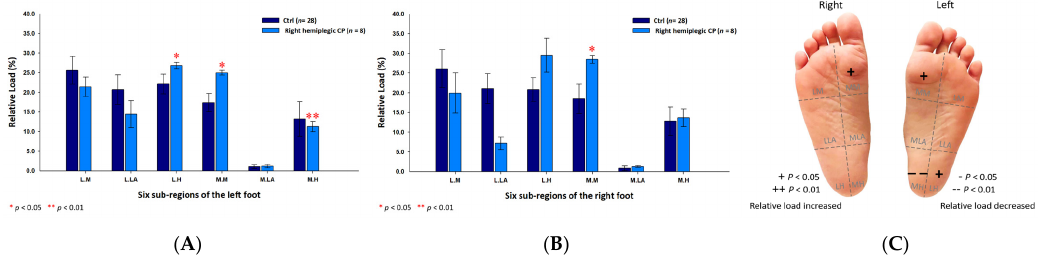
Figure 9. The percentage of six subregional relative loads of ( A ) left and ( B ) right feet in male students during static stance. The changes in pressure distribution are illustrated in ( C ) foot plantar diagram. Significant differences between the male control group and the male right hemiplegic CP group were determined as * p < 0.05 and ** p < 0.01.